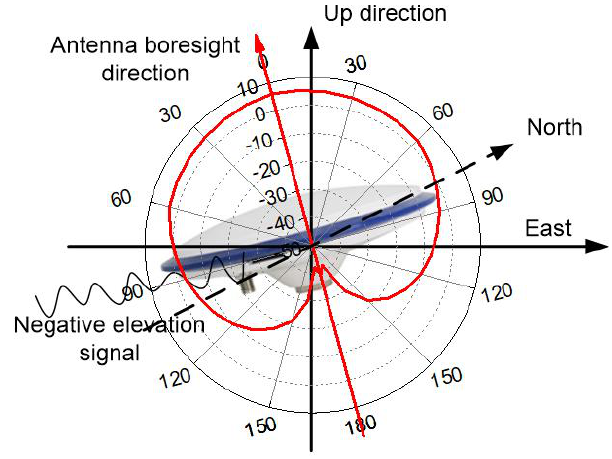
Figure 2. Sketch of the onboard GNSS antenna radiation pattern rotation. The red curve denotes the gain variation of signal strength. The rotation yields negative elevation signals and changes the noise characteristics.